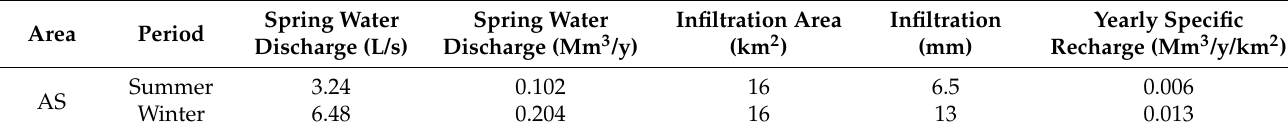
Table 11. Yearly specific recharge from total